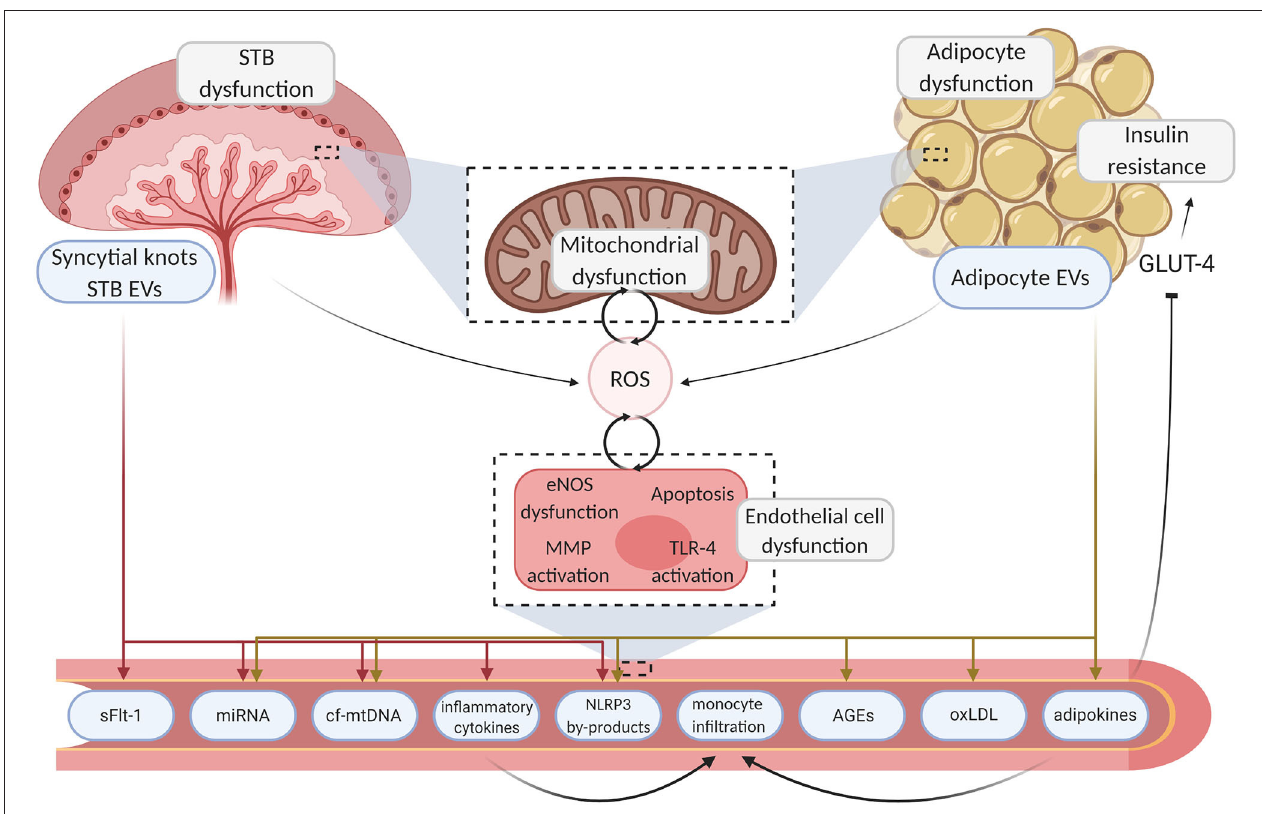
FIGURE 1 | Mechanisms linking placenta and adipose tissue dysfunction to endothelial damage. Aberrant endocrine organ dysfunction leads to excessive ROS generation and the release of inflammatory motifs from the placenta and adipose tissue. Deleterious motifs such as NLRP3 by-products, miRNA, inflammatory cytokines, and mtDNA enter the circulation, instigating various pathways which drive localized damage to the endothelium through inhibition of angiogenesis and inflammation. Sequential endothelial dysfunction ensues and pathogenic pathways such as TLR-4 driven cytokine production further upregulate ROS generation, creating a pernicious feedback loop. Maternal vasculopathy ensues, resulting in acute complications and poor chronic health outcomes. Created with BioRender.com. STB, syncytiotrophoblast; EV, extracellular vesicle; ROS, reactive oxygen species; GLUT-4, glucose transporter type 4; eNOS, endothelial nitric oxide synthase; MMP, matrix metallopeptidase; TLR-4, toll-like receptor 4; sFLT-1, soluble fms-like tyrosine kinase-1; miRNA, micro ribonucleic acid; cf-mtDNA, cell-free mitochondrial deoxyribonucleic acid; NLRP3, NOD-; LRR- and pyrin domain-containing protein 3; AGE, advanced glycation endproducts; oxLDL, oxidized low-density